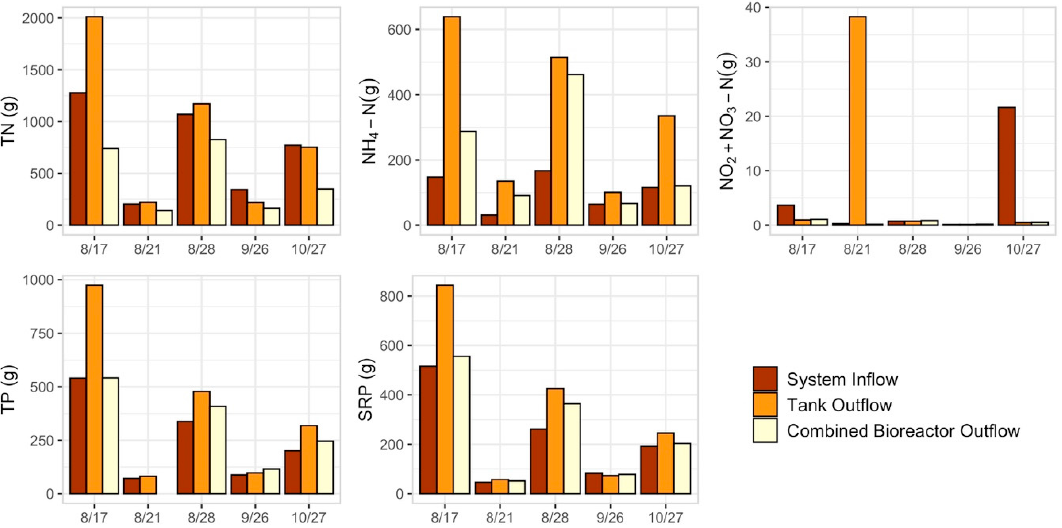
Figure 6. Nitrogen (N) and phosphorus (P) mass loads for five storm events where no tank bypass occurred, at the System Inflow, Tank Outflow, and Combined Bioreactor Outflows (i.e., from East and West Bioreactor Outflows). TN = total N, NH 4 + -N = ammonium-N, NO 2 − + NO 3 − -N = nitrite + nitrate-N, TP = total P, SRP = soluble reactive P.